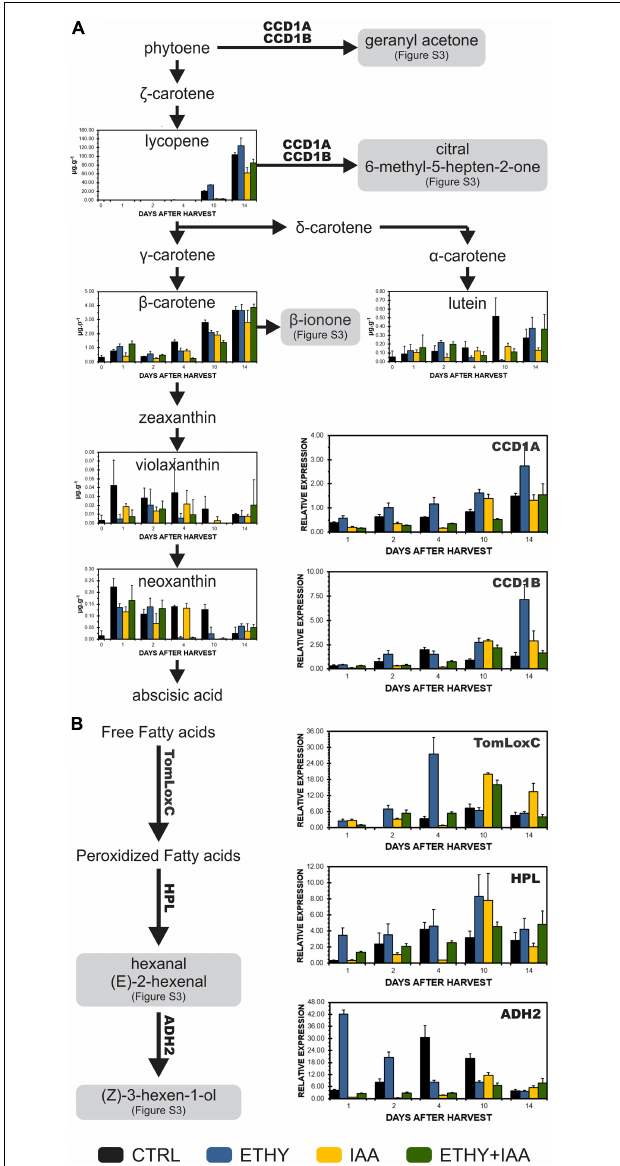
FIGURE 5 | Effects of ethylene, auxin, and both treatments on carotenoid contents and genes involved in the biosynthesis of VOCs during tomato ( S. lycopersicum L. Micro-Tom) fruit ripening. (A) Carotenoid content and CCD1A and CCD1B gene expression. (B) TomLoxC , HPL , and ADH2 gene expression. CTRL, control group. ETHY, ethylene-treated group. IAA, indole-3-acetic acid-treated group. ETHY + IAA, group treated with both hormones. CCD, carotenoid cleavage dioxygenase. LoxC, Lipoxygenase C. HPL, hydroperoxide lyase. ADH2, alcohol dehydrogenase-2. The contents of carotenoids are given in micrograms per gram of fruit on fresh weight basis. Vertical bars represent the standard deviation of three replicates ( n =